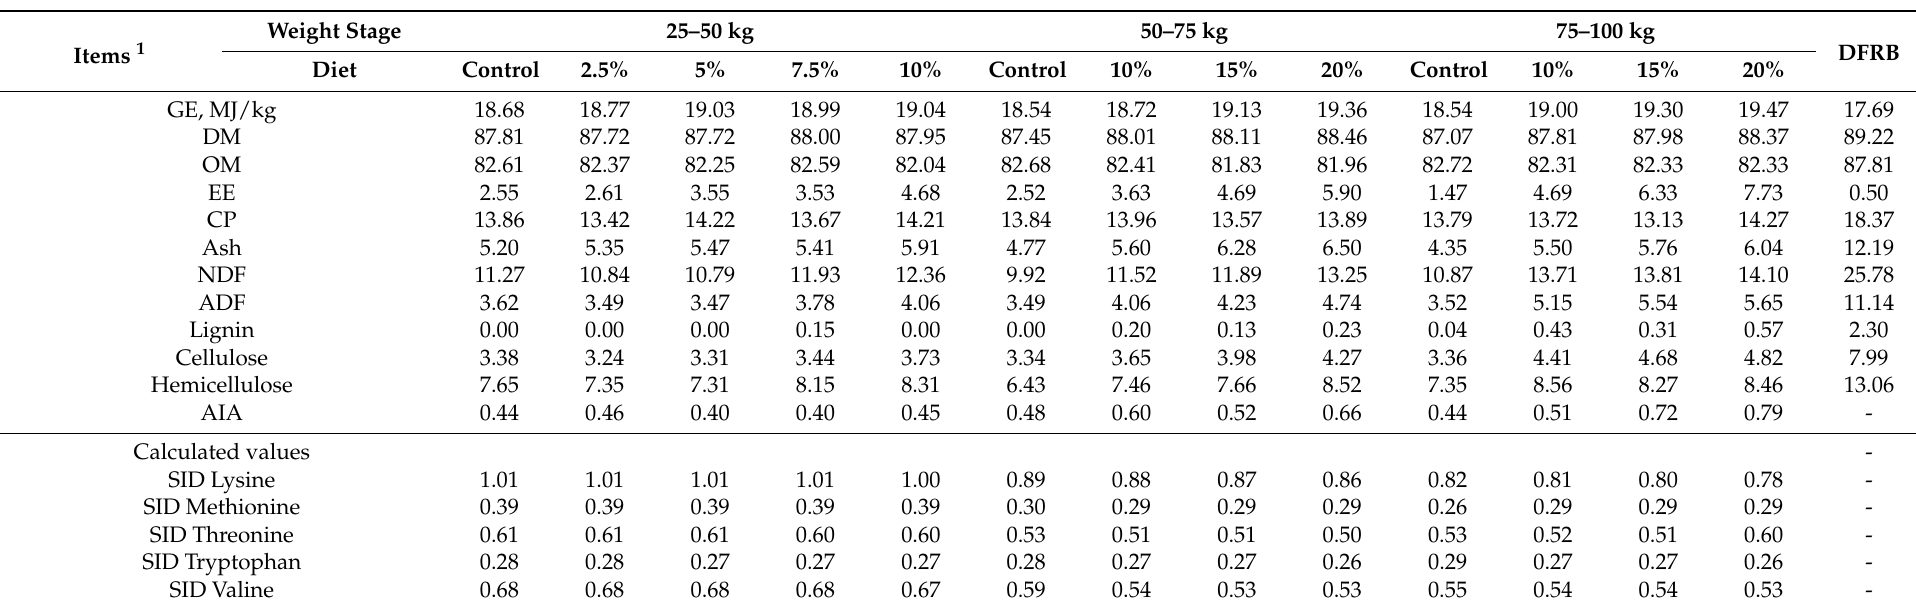
Table 2. Nutrient and marker levels of the experimental diets and ingredients (%, DM